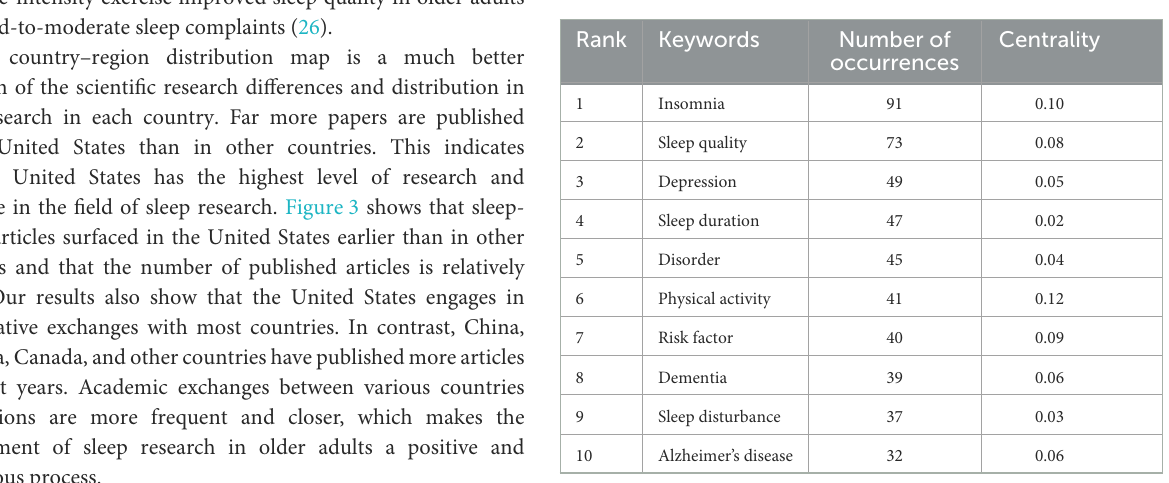
TABLE 6 Top 10 keywords co-occurrence